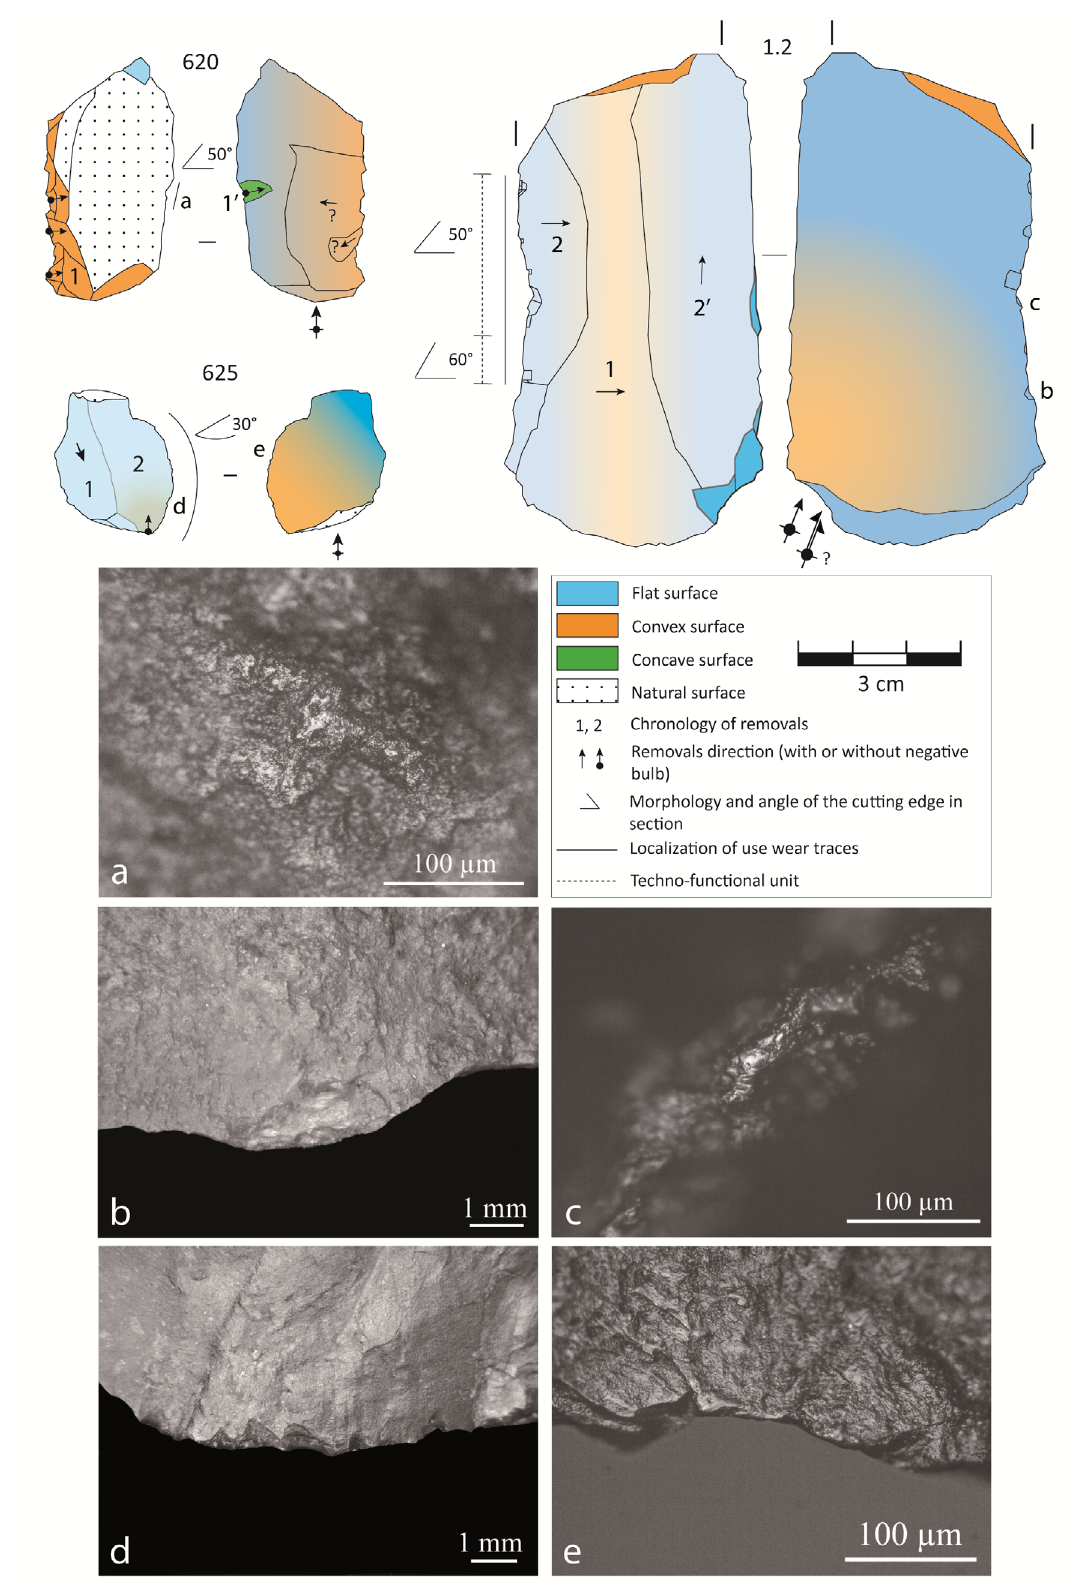
Figure 5: Diacritical sketches of lithics with use-wear traces and photos of traces. a. functional spot polish from flake 620 (used in a longitudinal motion possibly for butchering activities); b. and c. crushing and smooth spot polish visible on the cutting edge of flake 1.2 (used to process hard material in a longitudinal motion); d. and e. angular scars oblique to the edge, smooth spot polish and striations oblique to the edge of flake 625 (used in a longitudinal motion for butchering